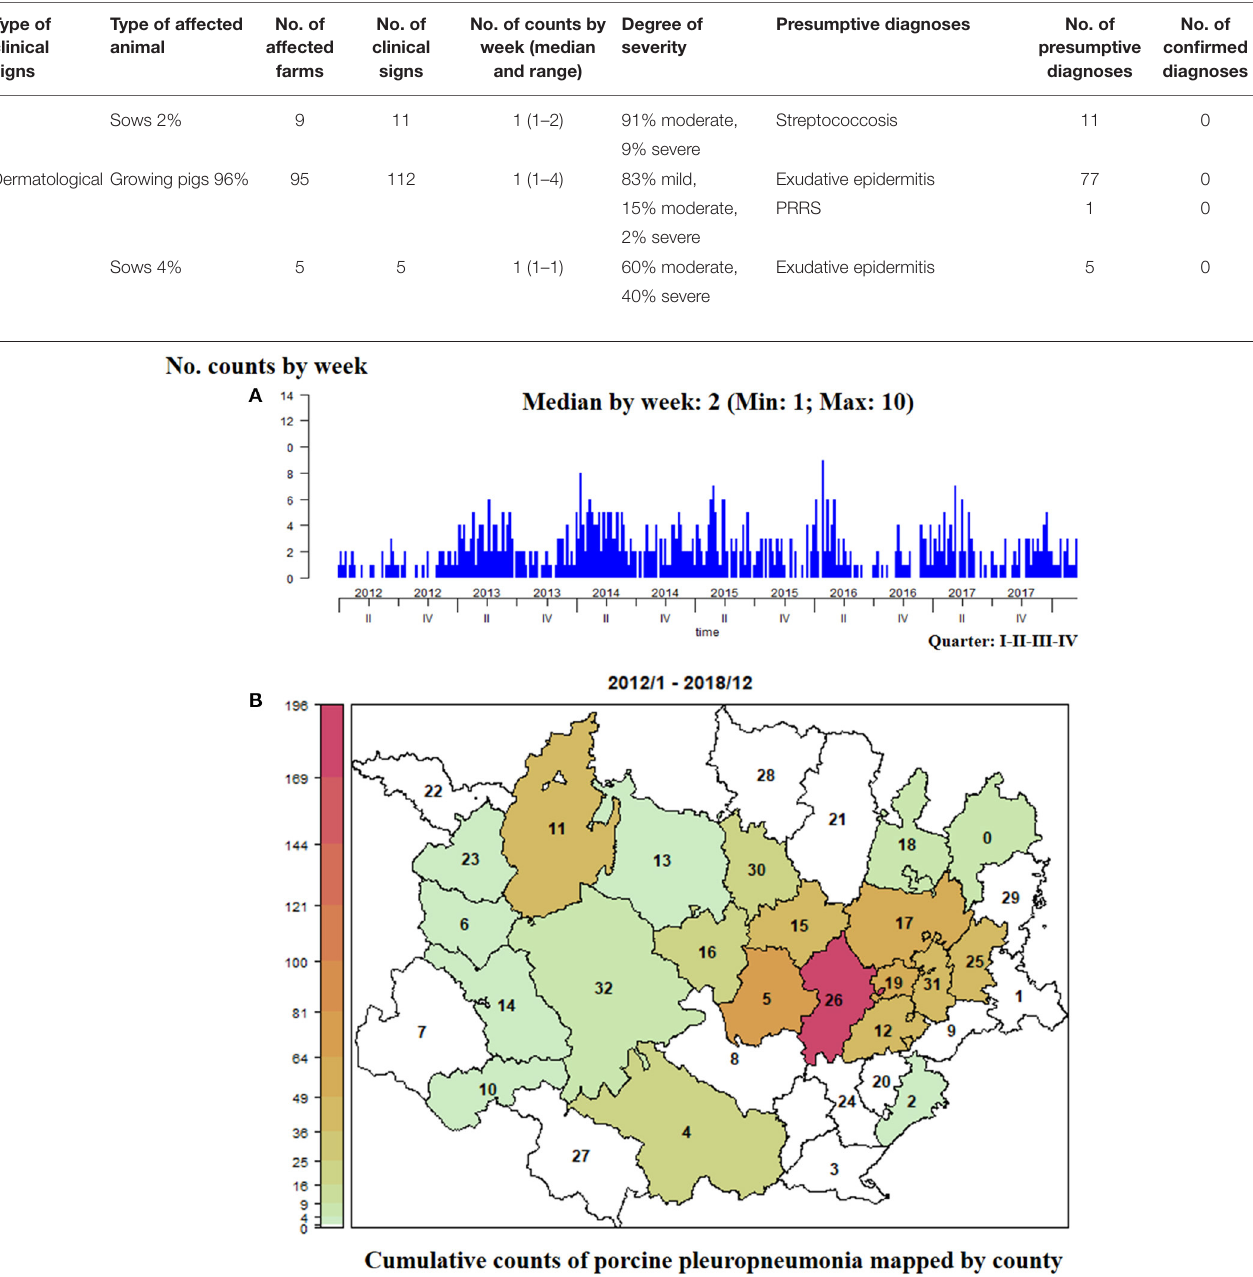
FIGURE 4 | Number of clinical events with porcine pleuropneumonia as presumptive diagnosis (January, 2012–March, 2018). (A) Counts reported by week. (B) Cumulative counts mapped by county.